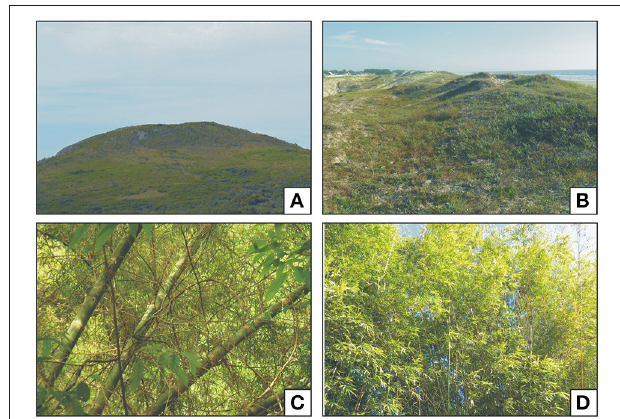
FIGURE 1 | (A) Grassland vegetation of Rio Grande do Sul, “Cerro do Ouro,” São Gabriel city. (B) Grassland of the coastal plain of RS, “Balneário Quintão,” Palmares do Sul city. (C,D) Riparian forest with lignified bamboos, Gravataí city.